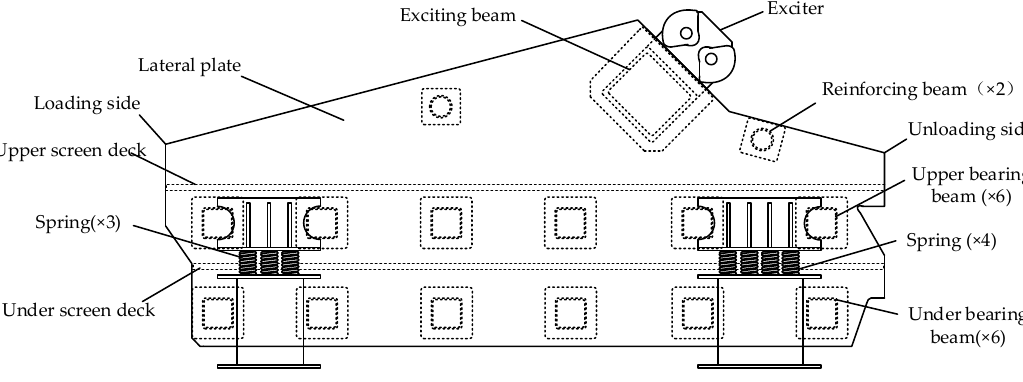
Figure 2. Structures of the SLK3661W double-deck linear mining vibrating screen.